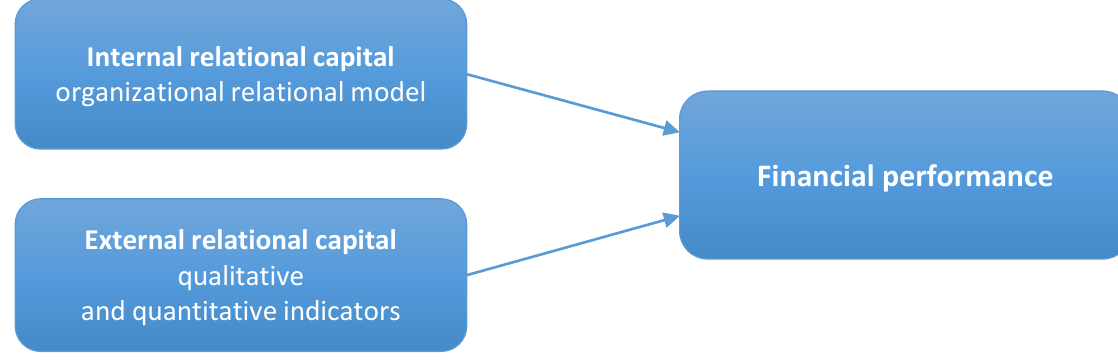
Figure 1. Research